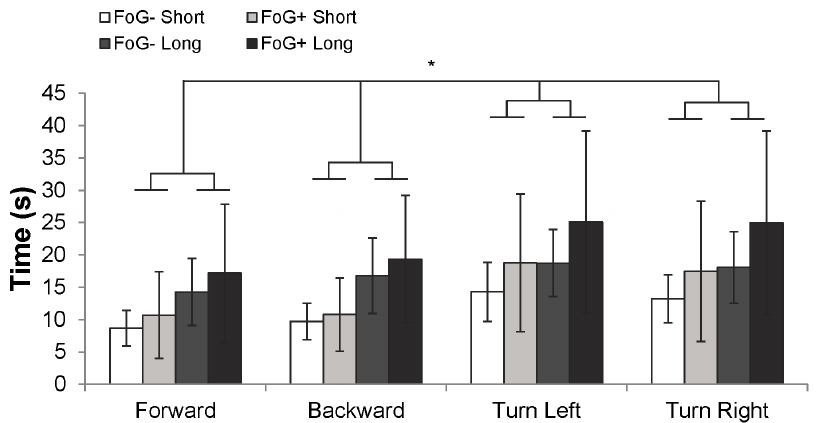
Figure 3. Gait imagery times in FoG 2 and FoG + during short and long gait imagery tasks. ‘‘Long’’ gait imagery tasks took significantly longer than ‘‘short’’ gait imagery tasks (denoted by *, F 1,16 =34.6; p , 0.001, repeated measures ANOVA). Differences between FoG + and FoG 2 did not reach significance.